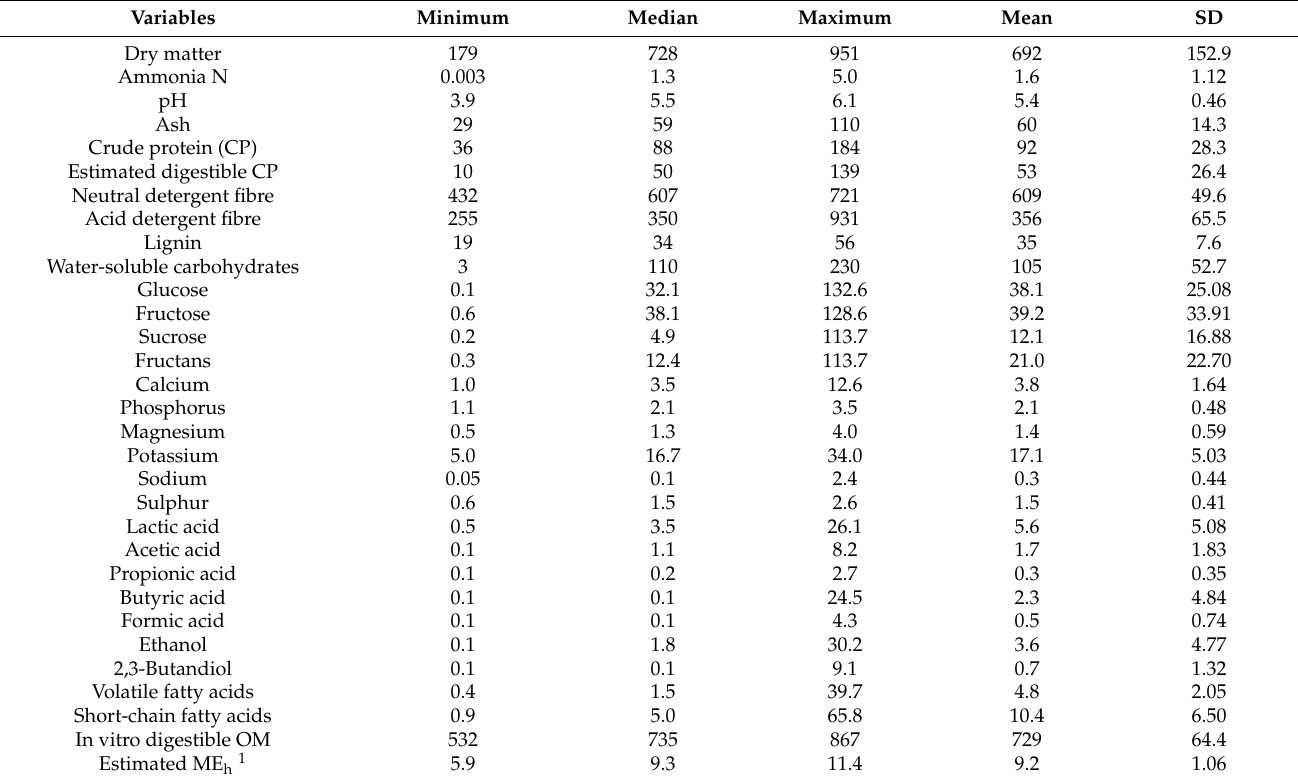
Table 1. Dry matter (DM, g/kg), ammonia N (% of total N), pH, chemical composition, in vitro organic matter (g/kg DM) and metabolisable energy (ME h, MJ/kg DM) in wrapped forages used for the horses in the study. Minimum, median, maximum, mean and standard deviation (SD) values for 50 forage batches with three replicate samples for each forage